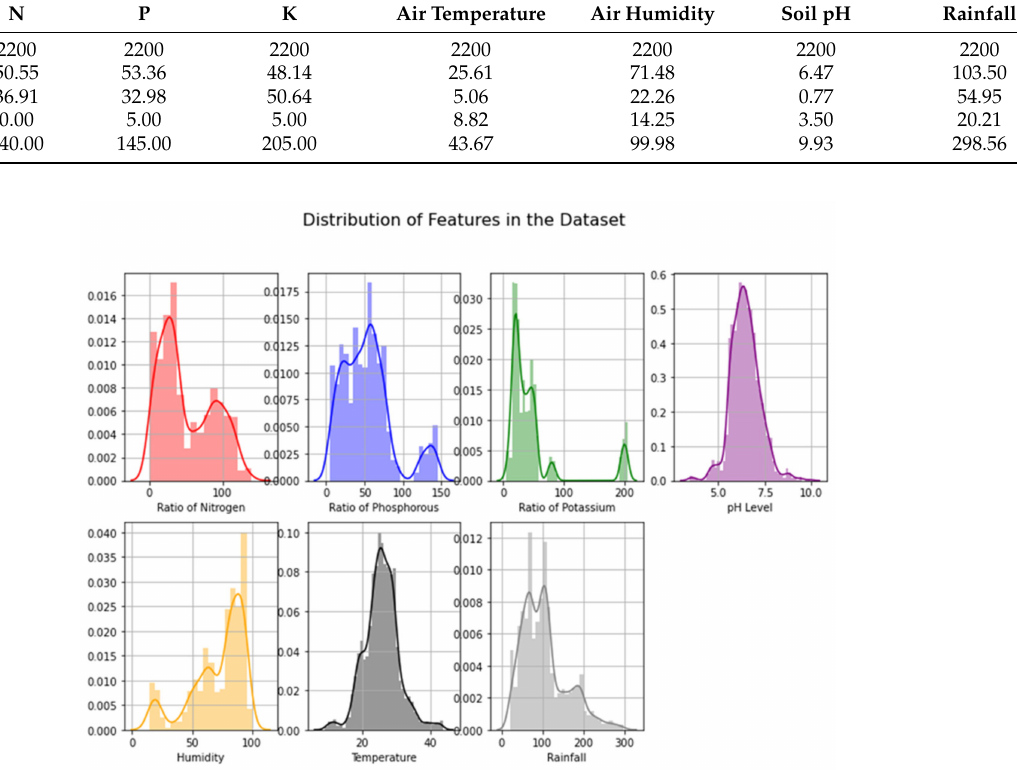
Figure 6. Distribution of features in the dataset.